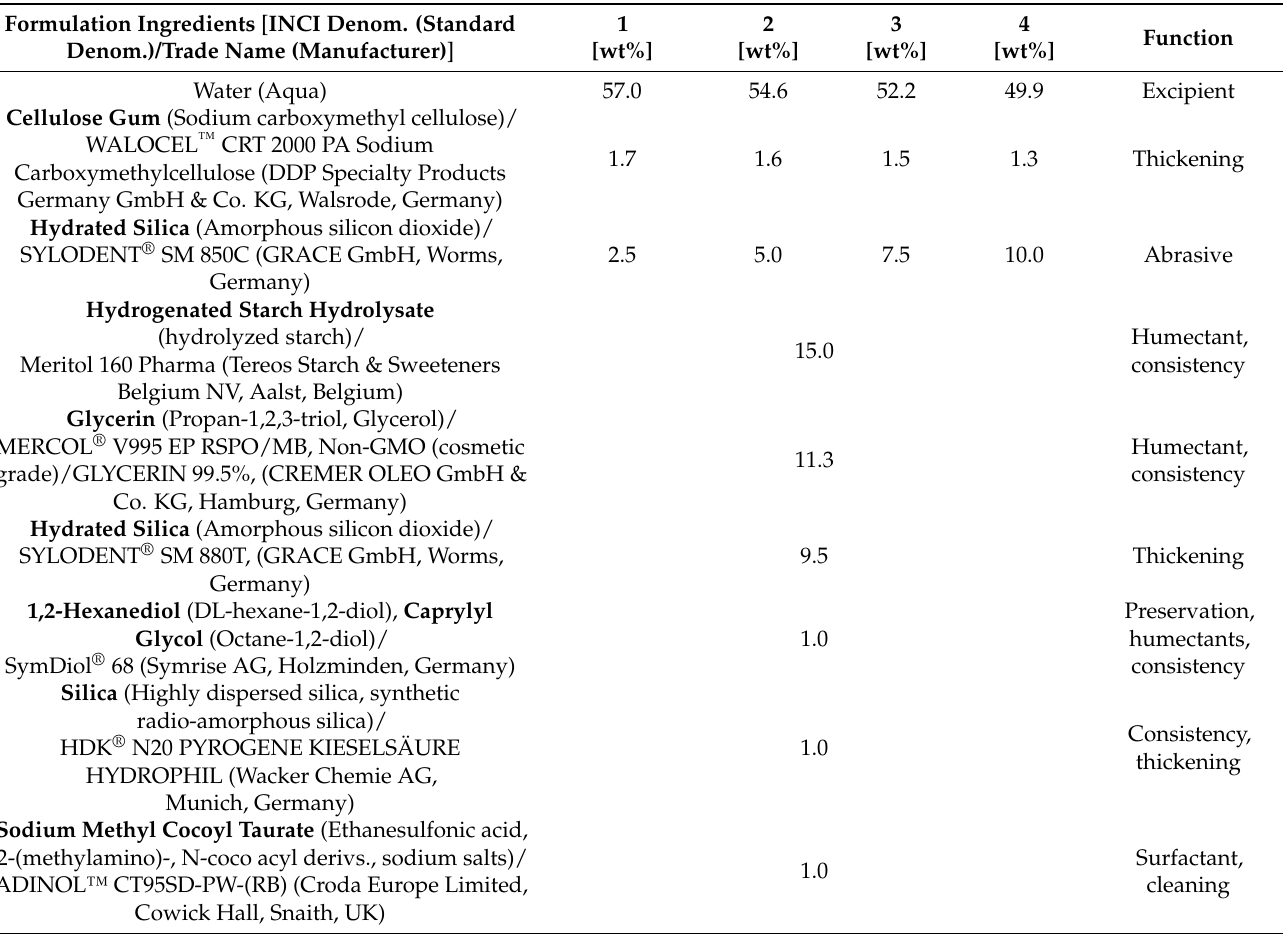
Table 1. Ingredients for producing the four model toothpaste formulations and their functions within the formulation (INCI: International Nomenclature Cosmetic Ingredients).